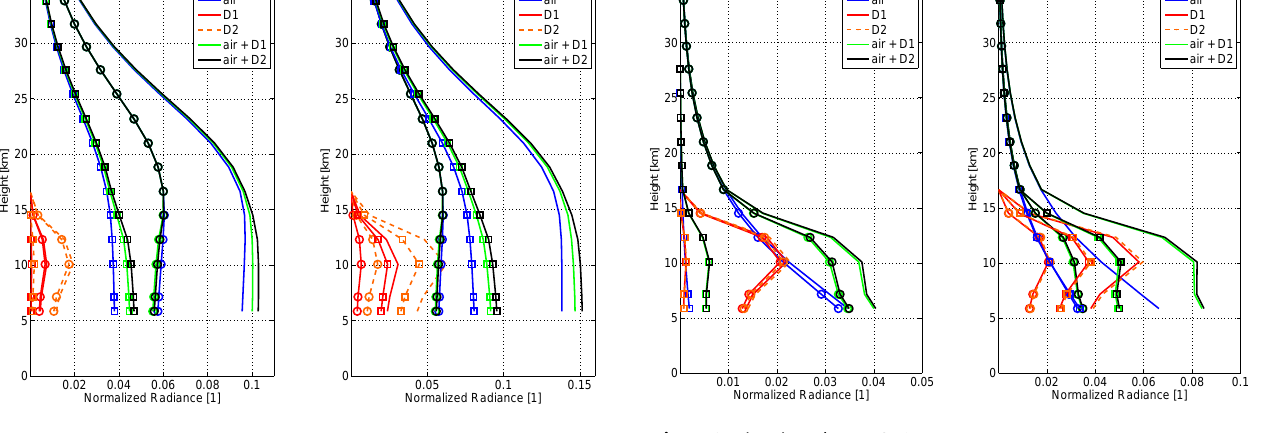
Fig. 2. As in Fig. 1 but at 377nm.